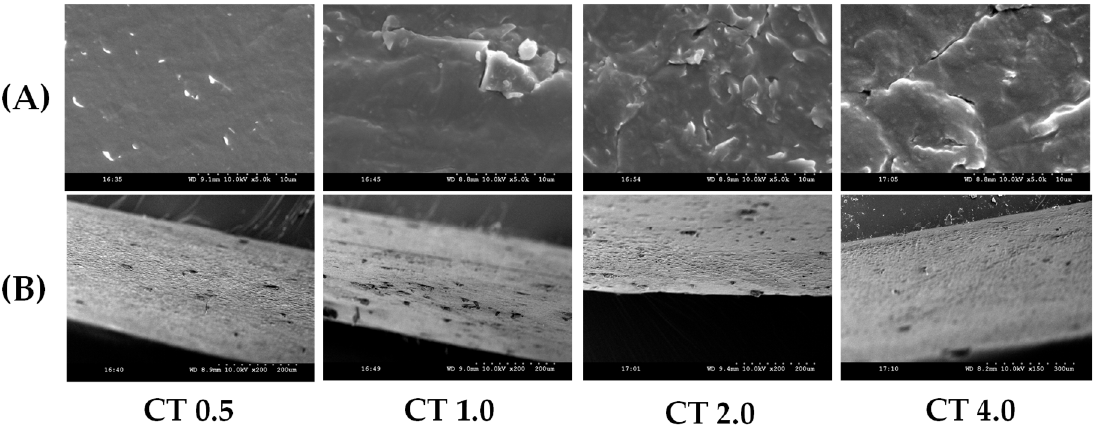
Figure 10. SEM Images: ( A ) Surface Morphology and ( B ) Cross-Section of NIPU Composite Films.